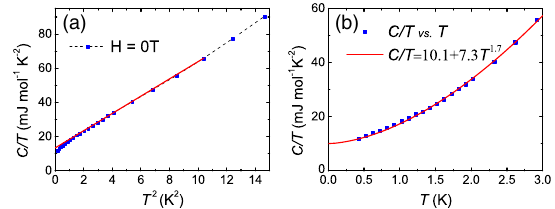
FIG. 3. Low-temperature specific heat of CsFe 4 − x Se 4 . (a) Quad- ratic temperature dependence of the specific heat coefficient C=T measured down to 0.4 K. The linear red curve gives the Debye model fit in the temperature range of 1.5 to 4 K, which yields a residual coefficient of about 13 . 6 mJ = mol-K 2 . (b) Temperature dependence of the specific heat coefficient C=T in the temper- ature region from 0.4 K to 3 K. The red curve gives a fitting with the formula C=T ¼ 10 . 1 þ 7 . 3 T 1 . 7 ð mJ = mol-K 2 Þ . A sizable residual specific heat coefficient can be